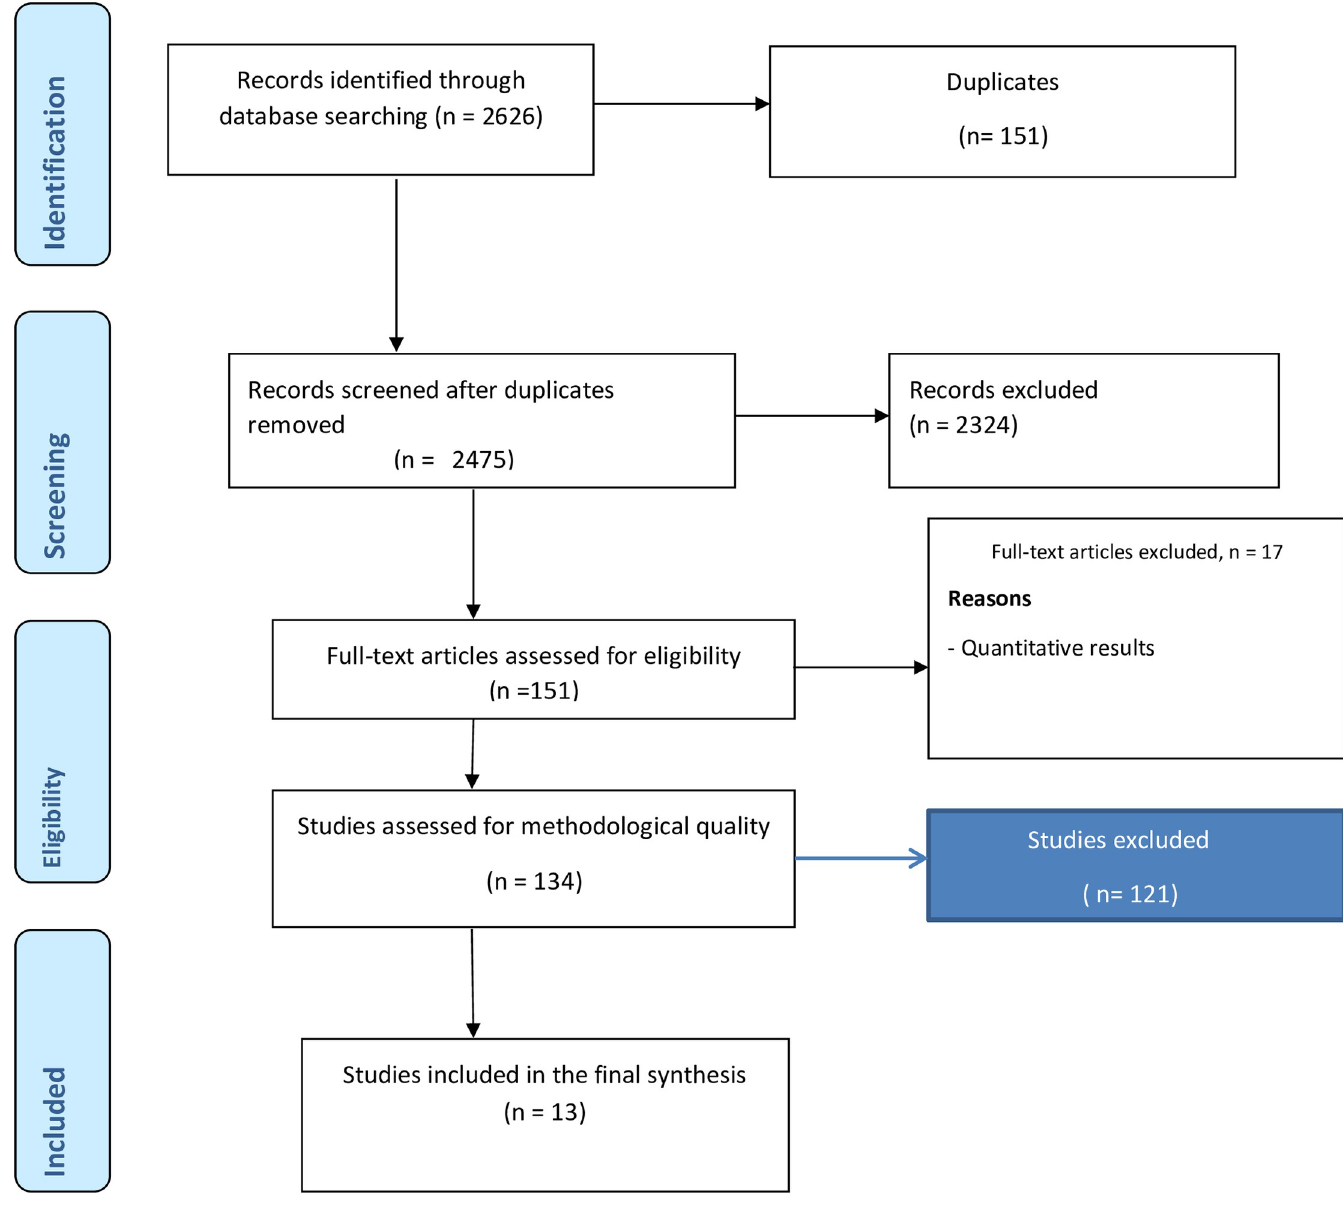
Fig 1. PRISMA flow